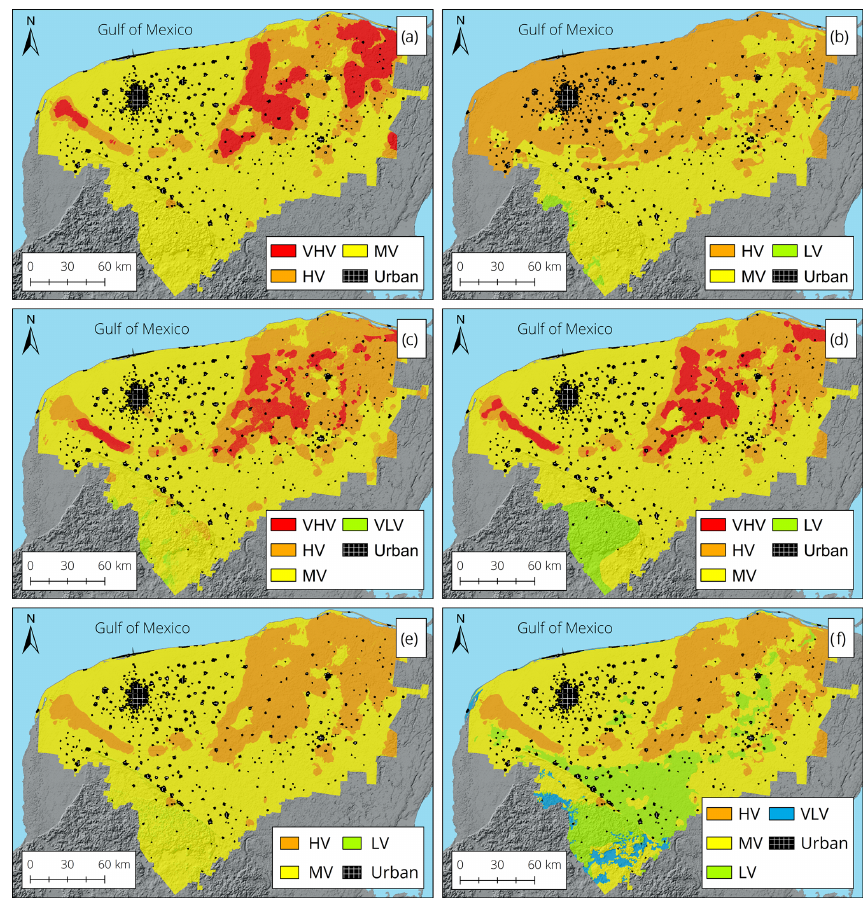
Figure C1. Vulnerability maps from methods previously applied in Yucatán: (a) EPIK, (b) PI, (c) DRISTPI, (d) KARSTIC, (e) RISKE, and (f) the Slovene approach (SA). Maps reproduced from Moreno-Gómez